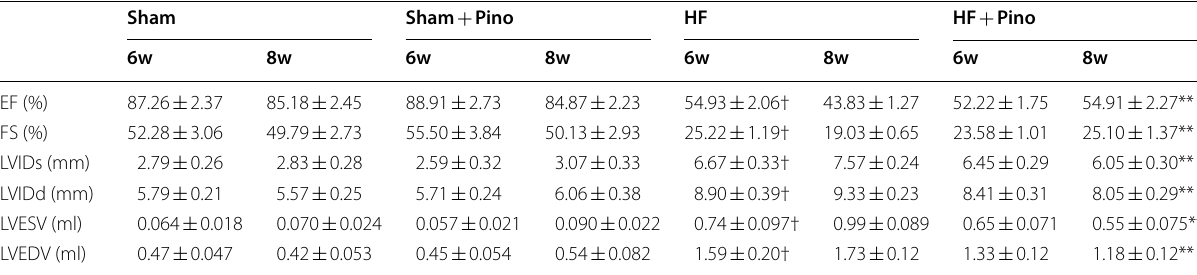
Table 1 The cardiac parameters obtained from M-mode echocardiogram